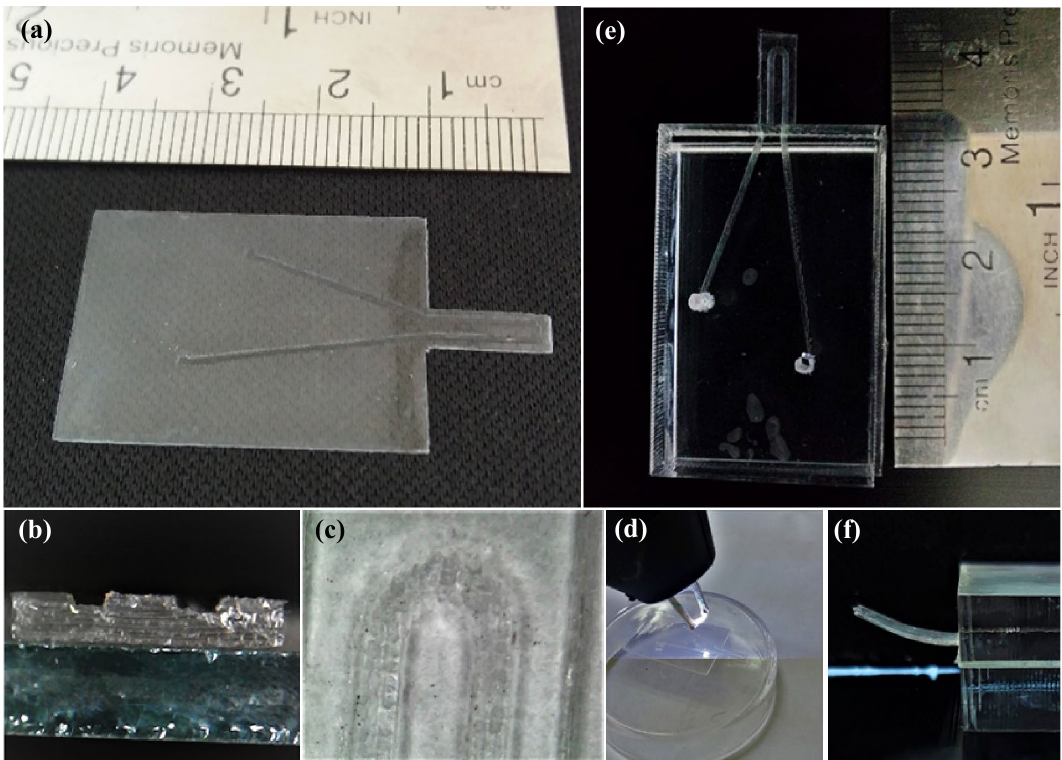
Figure 3. ( a – c ) Different cross views of PDMS film after engraving and cutting by CO 2 laser. ( d ) Polymer surface treatment through corona plasma before bonding two layers, ( e ) and ( f ) final shape of the sensor. Photos were taken by HiView v. 1.4 software (http:// www. hvscam.